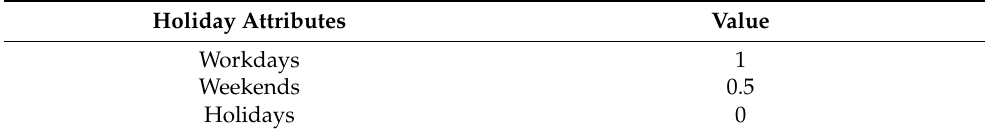
Table 2. Quantitative treatment table of holiday eigenvalue.